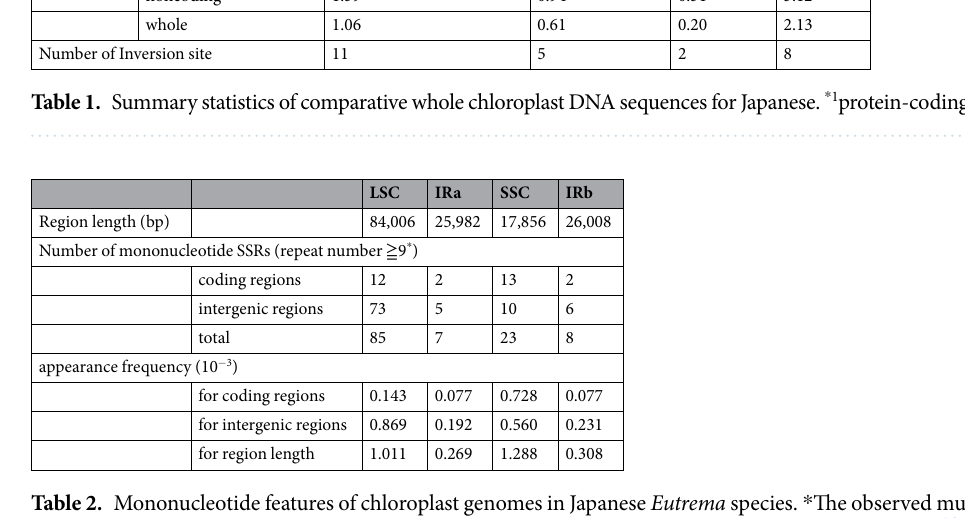
Table 2. Mononucleotide features of chloroplast genomes in Japanese Eutrema species. * The observed mutation rates increase significantly (homopolymer) when mononucleotide. repeat numbers reach or exceed 9 bp 16